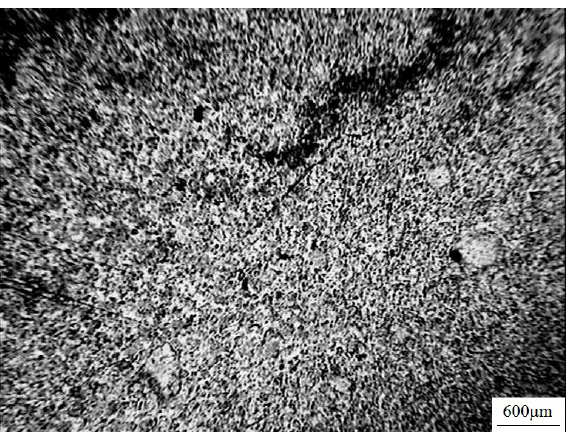
Figure 4. Microstructure of the specimen quenched with 9 Hz, 500 V, 9 min and 1200 μ F (cid:2) 50 . (2) The heat treatment with the PEF increased the Ac1 point to a higher temperature as much as 90° at least and maintains Ac3 point unchangeably. (3) The PEF can refine martensite (along with the refine- ment of the parent